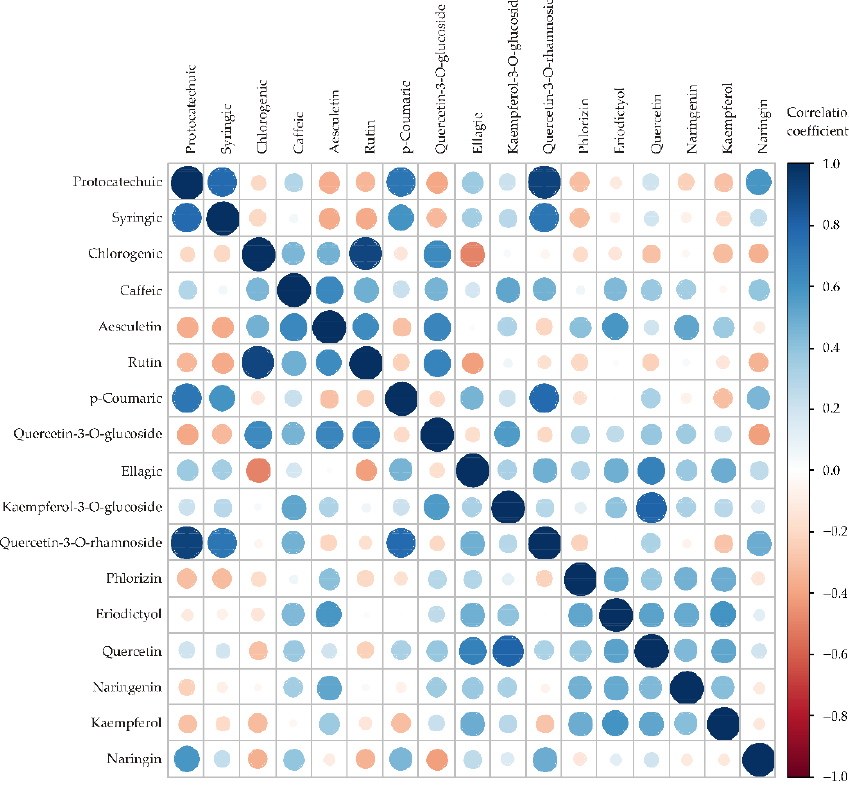
Additional Table caption: Table A1. Correlation between the average values of TPC